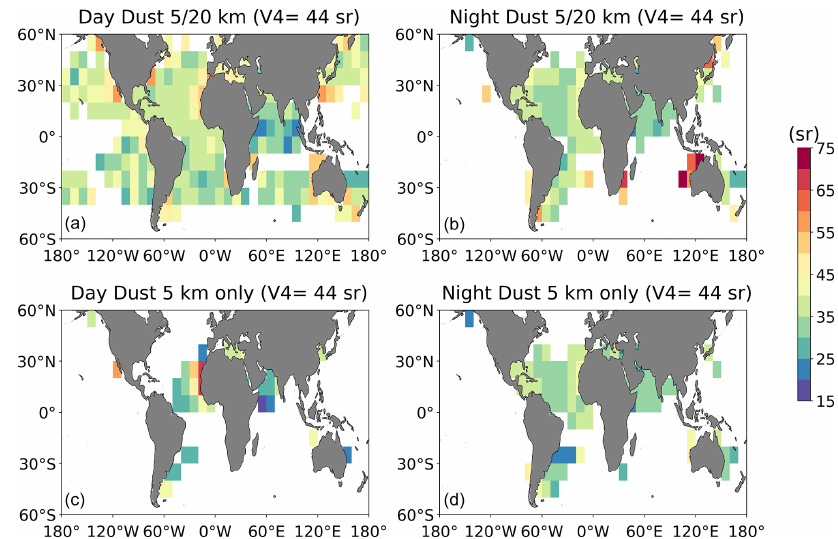
Figure 14. Daytime and nighttime CALIPSO–SODA lidar ratio maps for dust constructed using aerosol typing classification at 5 and/or 20km resolution (a, b) , and 5km only (c, d) . Values are reported for grids constructed with at least 20 samples.